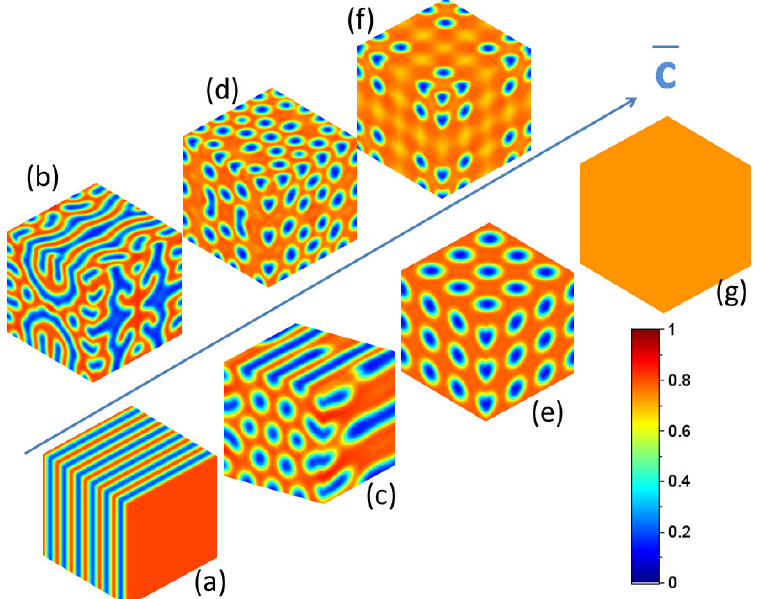
Figure 2. Simulation of 3D nano-patterns of Ag ¯ cCu irradiated with 1 MeV Kr ions at 330 K with a 1 − ¯ c flux of φ = 10 11 cm − 2 s − 1 . Different periodic microstructures emerge depending upon the average Ag concentration ¯ c (( a ): 1D stripes (S); ( c ): cylinders forming hexagonal patterns (C); ( e ): 3D body centered cubic structures (¯ c = 0.65) (B); ( g ) solid solution (¯ c = 0.75) (SS)). Micro-structures associated with the co-existence of such domains are also plotted (( b ): S+C; ( d ): C+B; ( f ): B+SS). The color stick defines the composition of radiation-induced nano-patterns. The blue and red colors refer to a null concentration of Ag and a null concentration of Cu